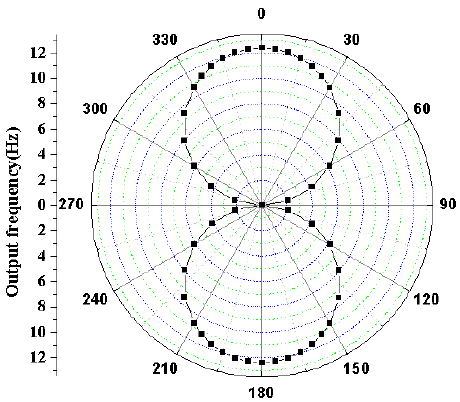
Figure 8. The simulation directivity of hair accelerometer using frequency output at an acceleration input of 1 g.